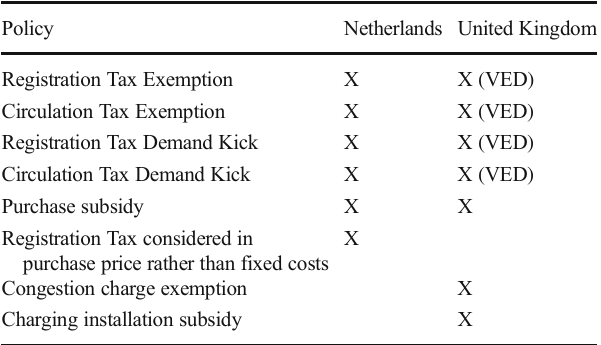
Comparison of variables considered in case study